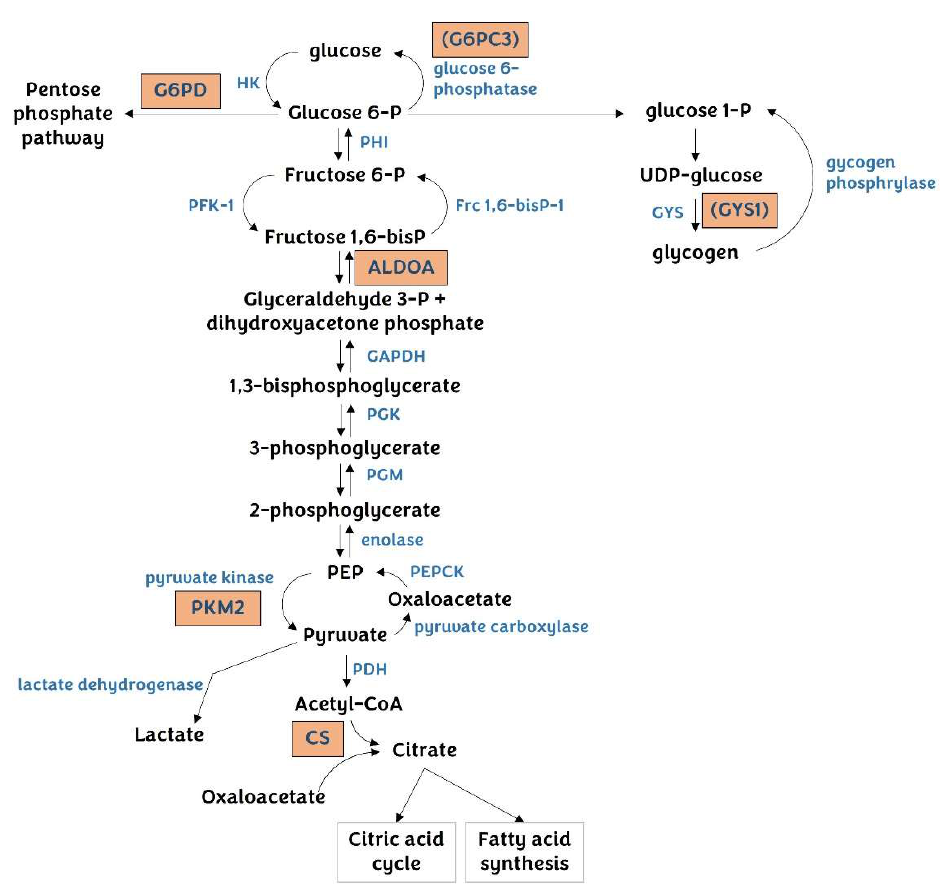
Figure 6. Regulation of glucose metabolism by miR-122 in hepatocellular carcinoma. miR-122 targets ALDOA and PKM2 in the glycolysis pathway. ALDOA is one of the key regulators in hepatocellular carcinoma (HCC) development, wherein its levels increase under hypoxic conditions in HCC cells. PKM2 is responsible for aerobic glycolysis, which is a prominent characteristic of cancer cells. PPP is activated in cancer cells, and G6PC is the enzyme that catalyzes the rate-determining step in the activation of PPP. CS catalyzes the biosynthesis of citrate, which is a key enzyme in fatty acid synthesis in HCC. G6PC3 is one of the isotypes of G6P that produces glucose from glucose 6-phosphate in the gluconeogenesis pathway. GYS1 mediates the synthesis of glycogen. Although G6PC3 and GYS1 are direct targets of miR-122 in HCC, the functional link of these enzymes to HCC is not clear yet.